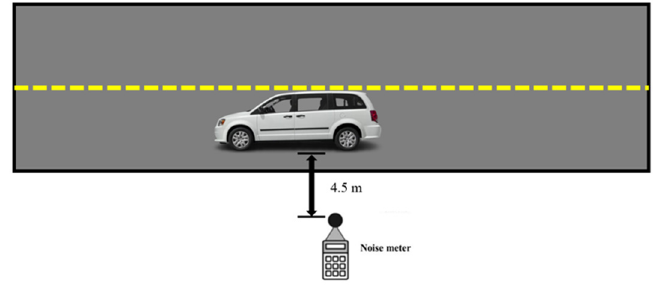
Figure 5. Demonstration of the noise measurement procedure.